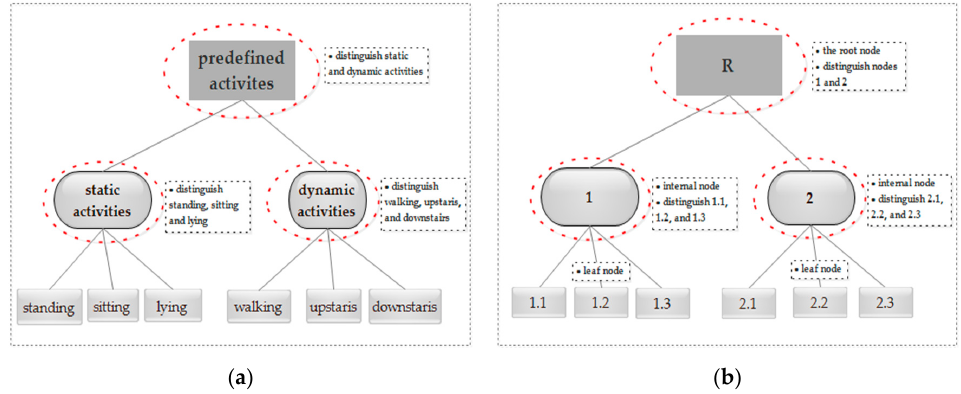
Figure 2. The proposed hierarchical activity recognition framework. The framework essentially organizes the predefined activities of interest into a hierarchical tree that indicates the relationship among different activities. ( a ) An example of a hierarchical activity recognizer; ( b ) Abstract form of the corresponding hierarchical structure.